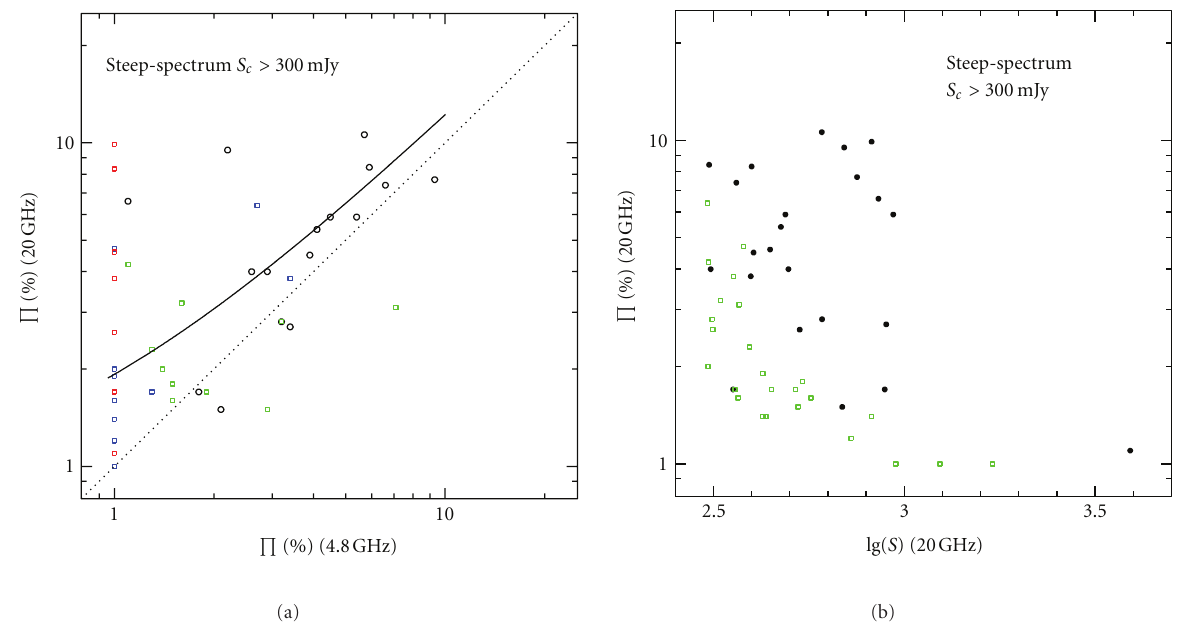
Figure 4: Fractional polarization for steep-spectrum sources at 20 GHz as a function of fractional polarization at 4.8GHz (a) and of flux density at 20 GHz (b). Points of di ff erent colours have the same meaning as in Figure 3.